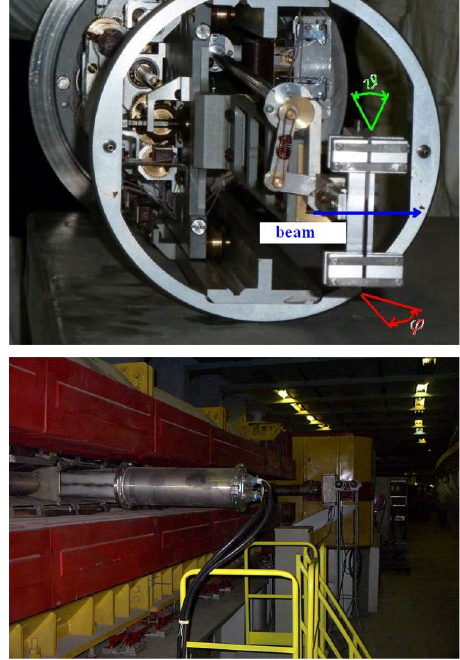
FIG. 1. The crystal in the double-axis goniometer is set in the ring of